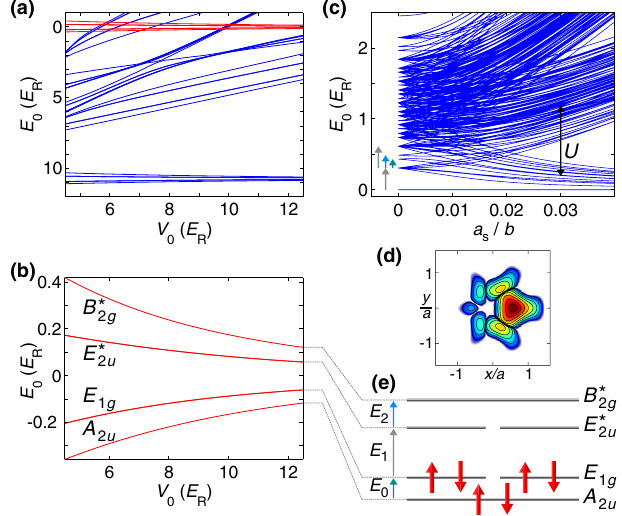
FIG. 3. Interactions in the conjugated π system. (a) Single- particle energy spectrum showing the lowest orbitals ( p orbitals z in red) as a function of the lattice depth V 0 (taking the role of the effective nuclei distance R 0 ). See Appendix A for parameters. The energy of the p orbitals can be tuned independently by z lattice depth V 0 (here, 35 E ). (b) Close-up showing only the p z R z orbitals with three bonding and three antibonding orbitals, where the orbitals 2-3 and 4-5 are degenerate. (c) Energy spectrum of the conjugated system incorporating the on-site interaction U for V 0 ¼ 6 E (see Appendix C). The colored arrows indicate the R lowest excitations [labeled in (e)] for vanishing interaction. (d) Logarithmic density plot of the two-dimensional Wannier function for the p (or s ) band. Each contour indicates a density z drop by a factor 1 = 10 . (e) Level scheme depicting orbitals and spin